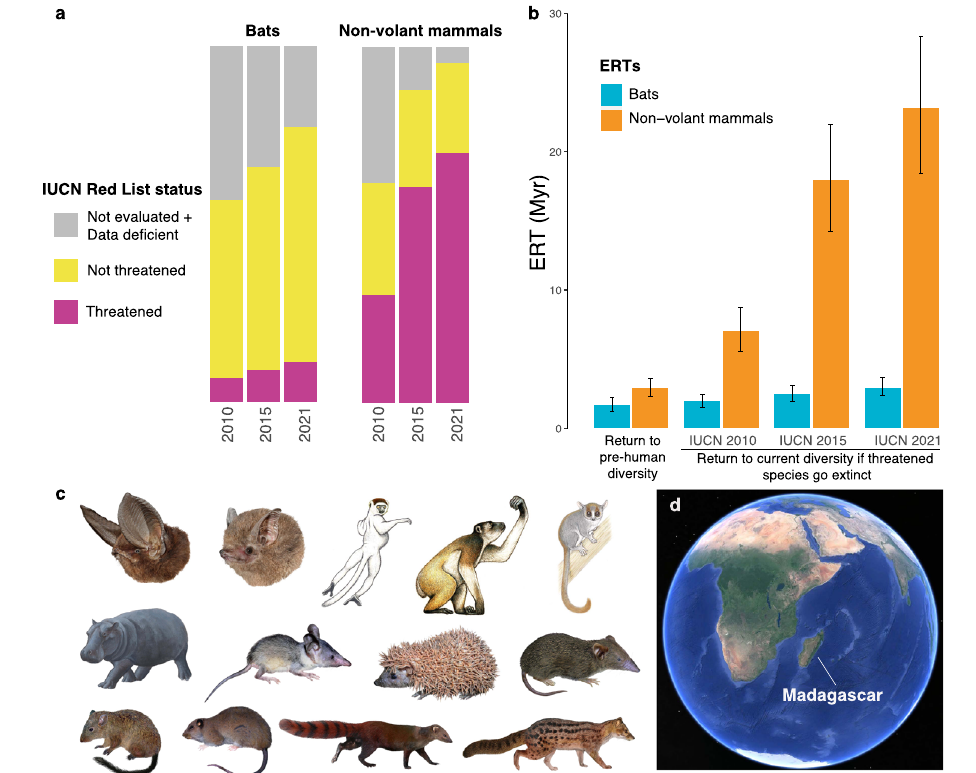
Fig. 2|IUCN statusofMalagasy mammalsandtheassociated ERTs.a Changein IUCN Red List status between 2010 and 2021 for species of bats and non-volant mammals. IUCN Categories: Not threatened: includes Least Concern and Near Threatened; Threatened: includes Vulnerable, Endangered and Critically Endan- gered. b The evolutionary return times (ERTs) in millions of years (Myr) estimated for different scenarios of human impact for the main dataset (D1) under the M26 model. Barplots show the mean values and the error bars are the 2.5 – 97.5 per- centilesacrosstheposteriordistributionoftrees, n =1000(fulldistributionshown in Fig. 3). c Examples of extant and extinct Malagasy mammals. From left to right,